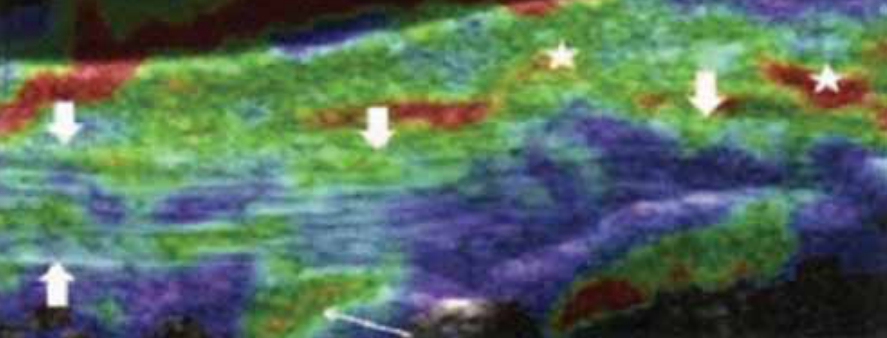
FIGURE 5. normal elasticity of insertional portion of Achilles tendon in a health volunteer. longi- tudinal rtse scan shows “hard” structured tendon (thick arrows, blue to green-coloured) and “soft” (yellow to red-colored) retrocalcaneal bursa (thin arrow) and and peritendinous tissue